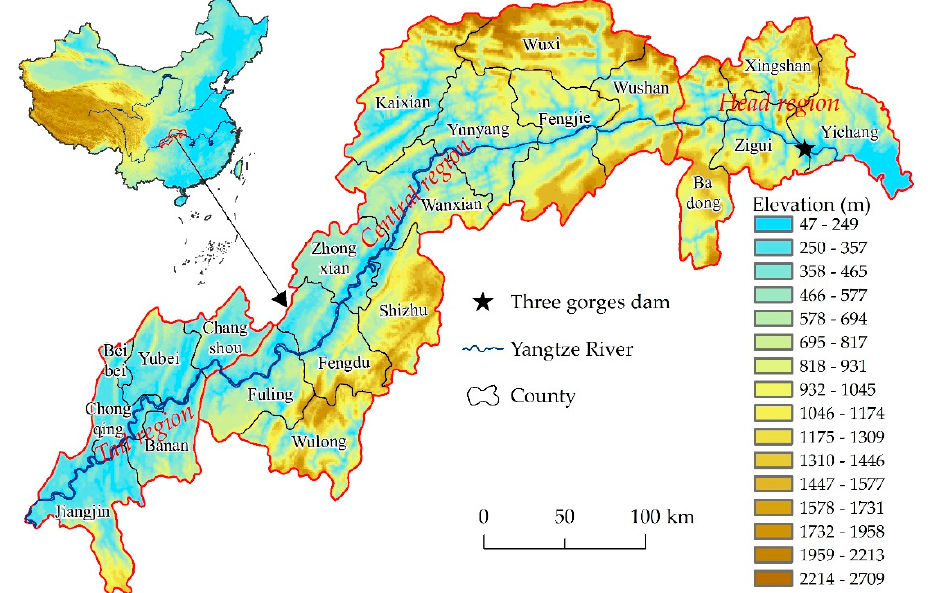
Figure 1. Location of the Three Gorges Reservoir Area (TGRA). The TGRA can be divided into three parts: head, central, and tail regions. The division between head and central regions is the provincial boundary of Hubei Province and Chongqing Municipality. The digital elevation model (DEM) was downloaded from Geospatial Data Cloud.